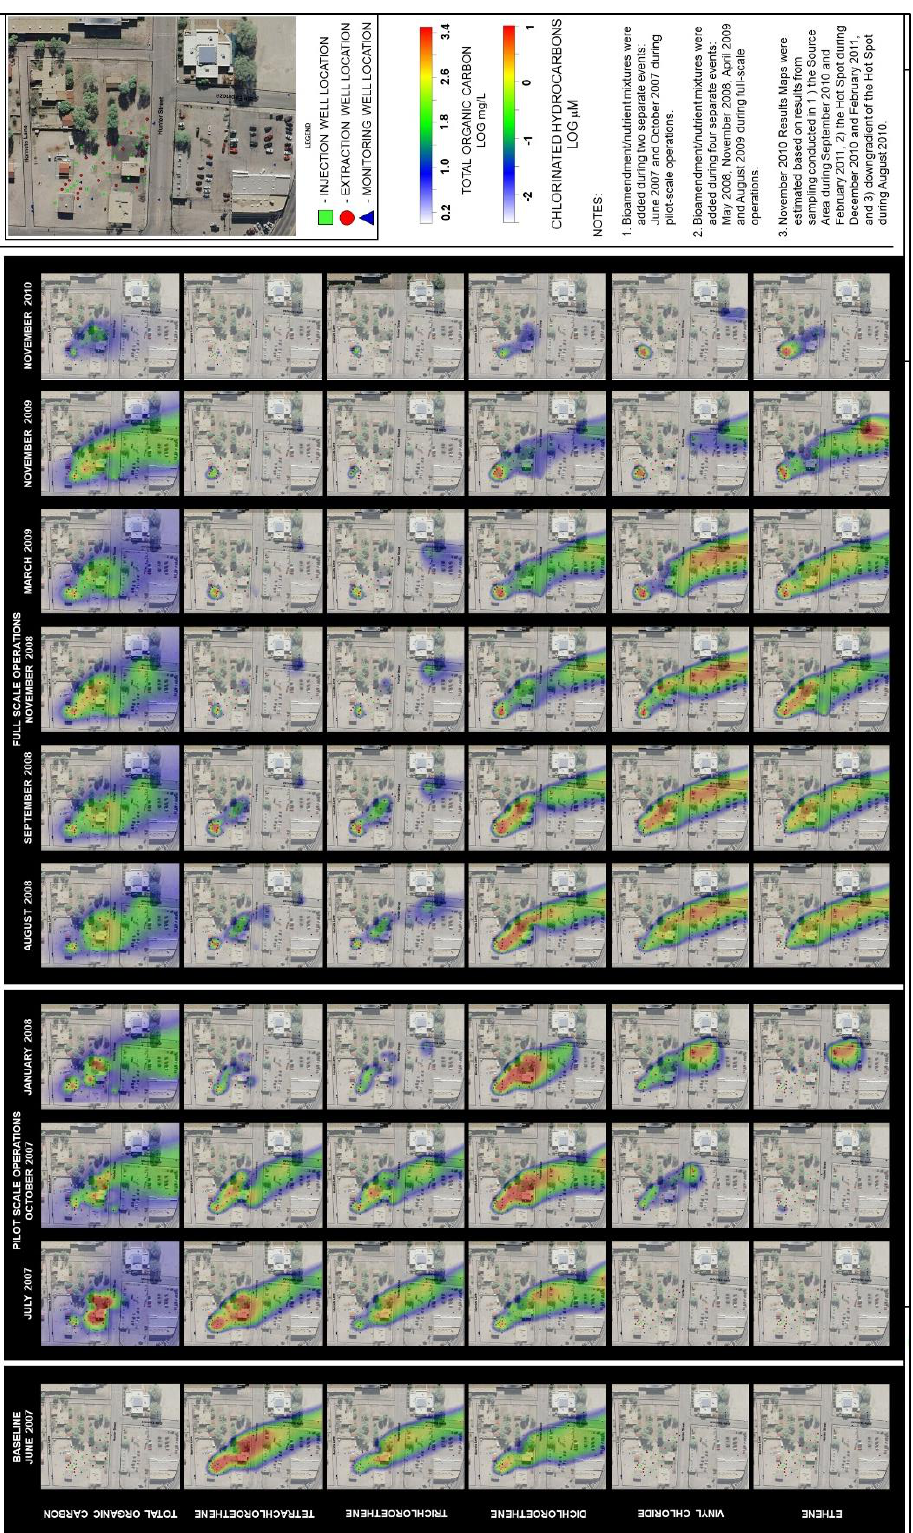
Figure A1. Heat map of bio-amendment addition (TOC) and dissolved chlorinated hydrocarbon during and following the pilot test.